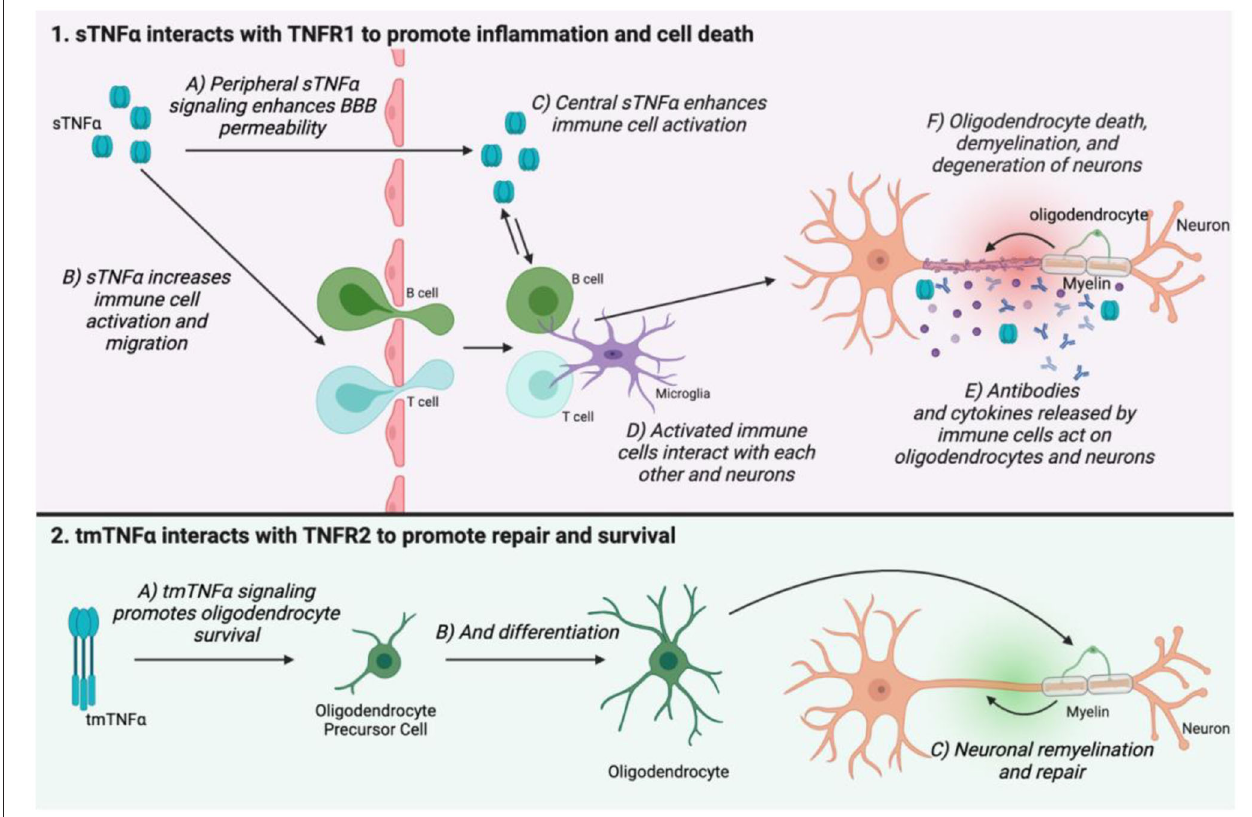
FIGURE 3 | The two TNF α isoforms and their receptors have opposing actions on MS disease progression. sTNF α interacts with TNFR1 in the peripheral nervous system to enhance BBB permeability (1A), as well as increase immune cell activation and migration (1B). TNF α can migrate across the weakened BBB, but it is also produced in the central nervous system where it again promotes immune cell activation (1C,D). Immune cells secrete antibodies and cytokines which mediate oligodendrocyte death, demyelination, and neuronal damage (1E,F). tmTNF α interacts with TNFR2 to promote oligodendrocyte survival and differentiation. This helps to promote remyelination and repair (2C). This figure was made using